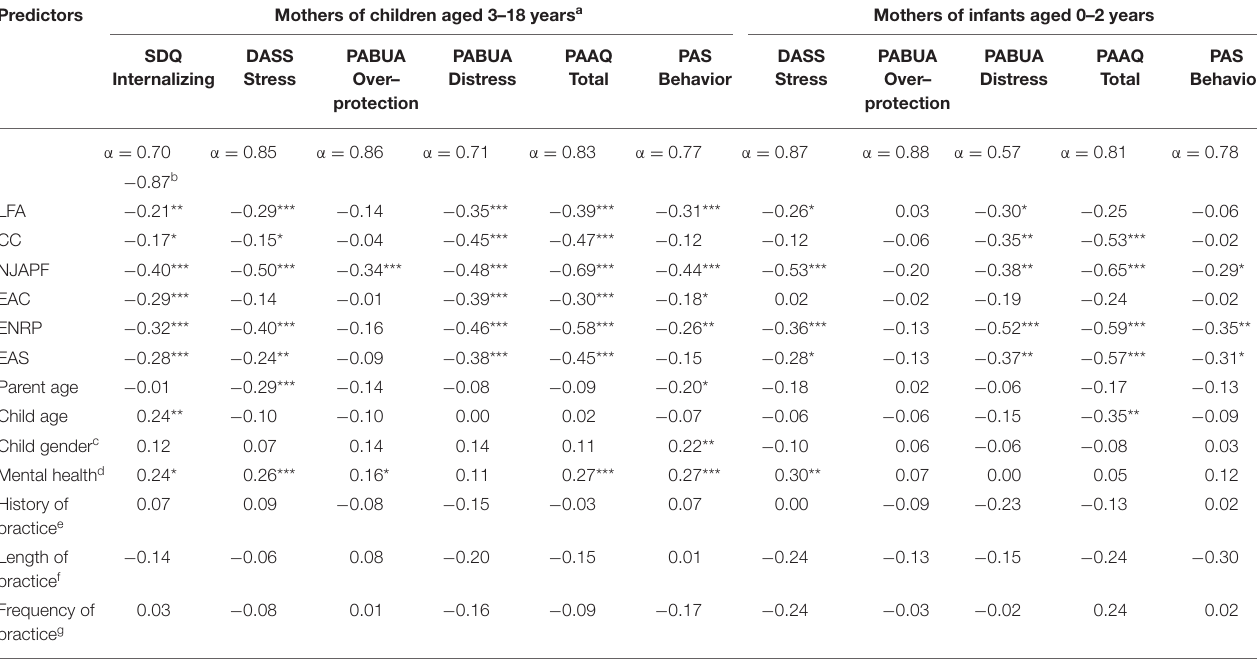
TABLE 5 | Correlations between IMP subscales, demographic and mindfulness practice variables, and outcome variables, for mothers of children and infants.